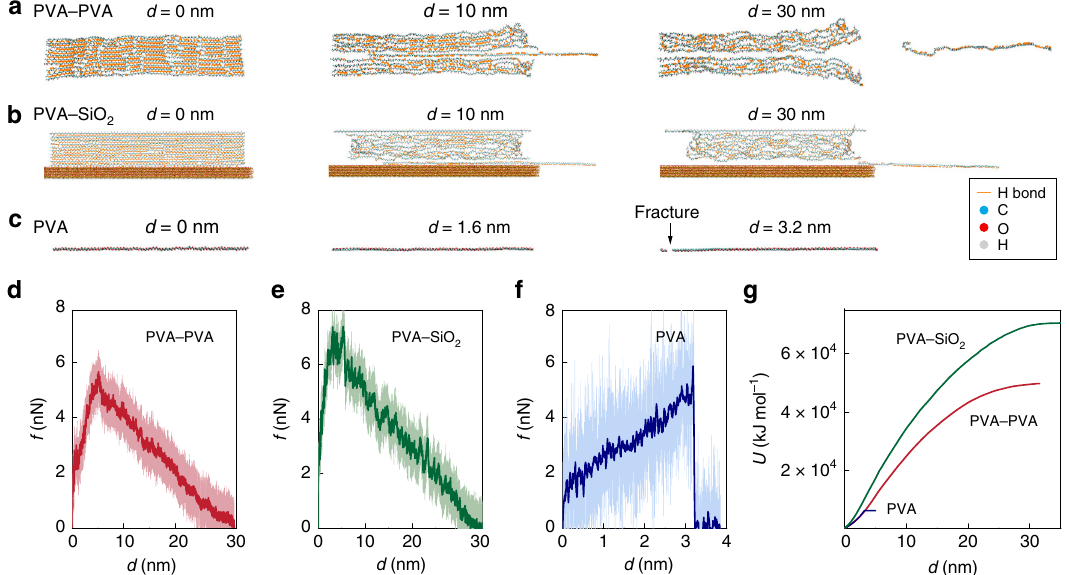
Fig. 4 Mechanism for fatigue-resistant hydrogel adhesion from simulations. a An image sequence of pulling out a PVA polymer chain (30 nm in counter length) from a nanocrystalline domain (PVA – PVA) at different applied displacements d using molecular dynamics simulation. b An image sequence